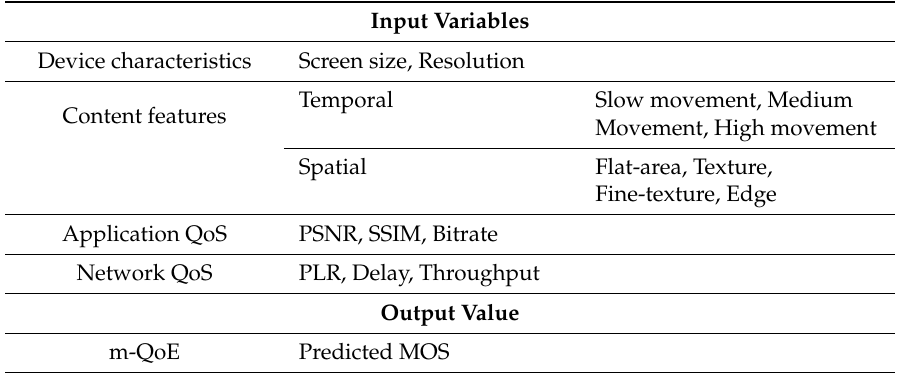
Table 5. Input and output